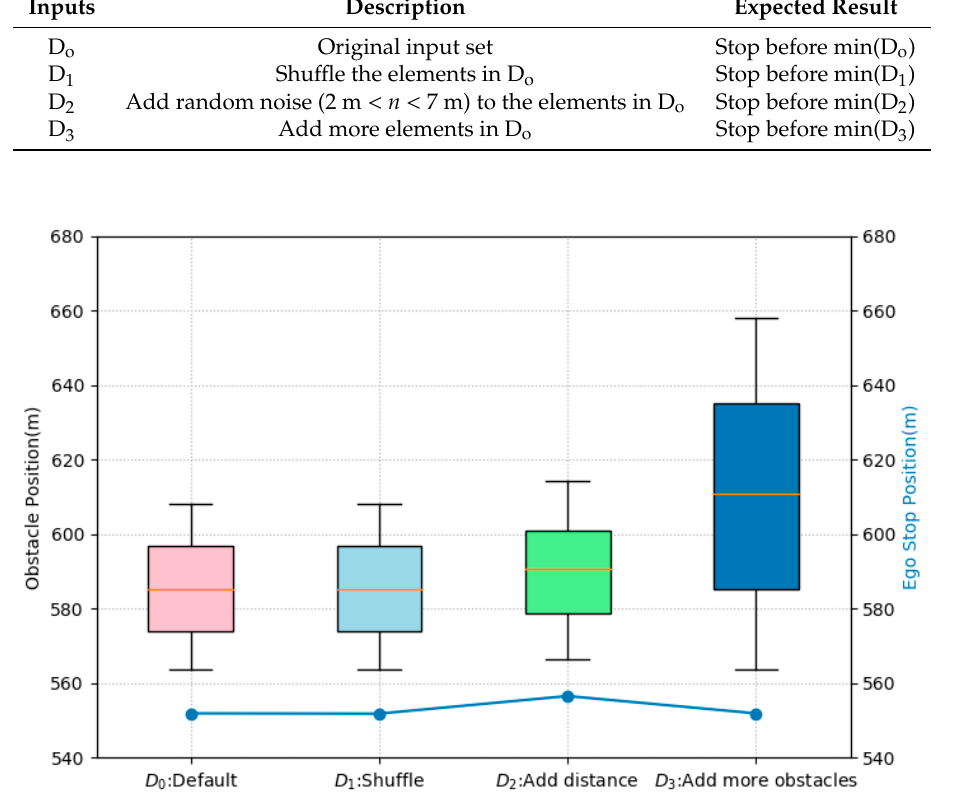
Figure 13. Ego-vehicle stop with obstacle position.